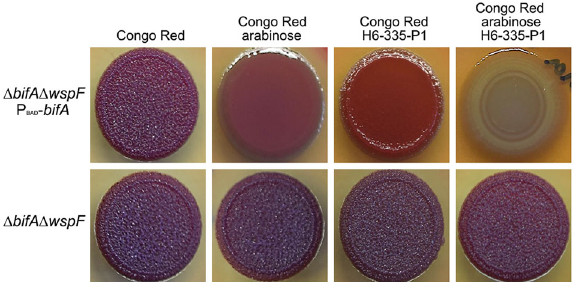
Fig. 8 The presence of H6-335-P1 results in activation of the BifA protein. Macrocolonies were grown from 5 μ l overnight culture of P. aeruginosa Δ bifA Δ wspF P BAD - bifA or P. aeruginosa Δ bifA Δ wspF spotted on agar plates supplemented with, respectively, Congo Red, Congo Red and arabinose, Congo Red and H6-335-P1, or Congo Red, arabinose and H6-335-P1. Photographs of the macrocolonies were acquired after 48 h incubation at